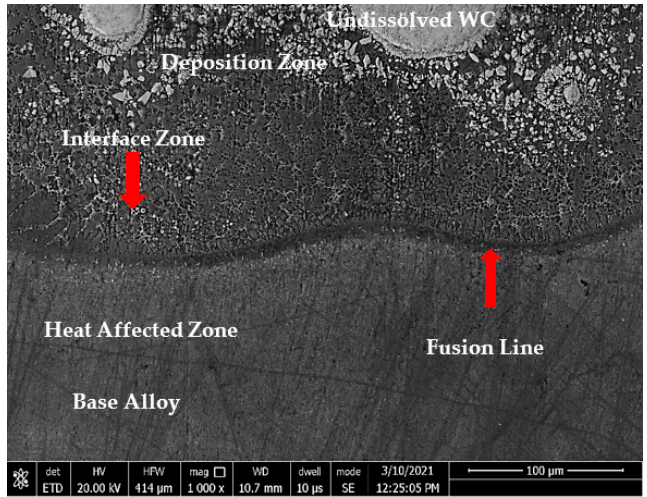
Figure 14. FESEM micrograph of a cross-section of sample 3’s whole deposited layer showing three different zones: deposition, interface, and HAZ.